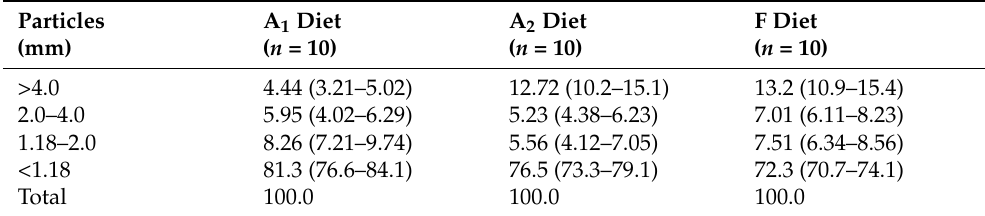
Table 9. Overall mean of faecal particle size of the animals fed finishing diets for slaughter. Values expressed in